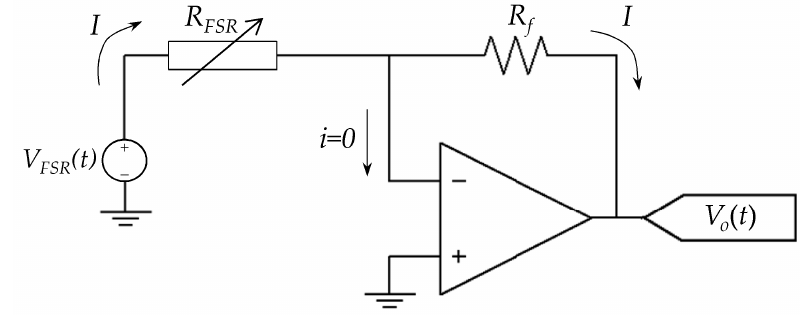
Figure 10. Driving circuit for the FSRs.